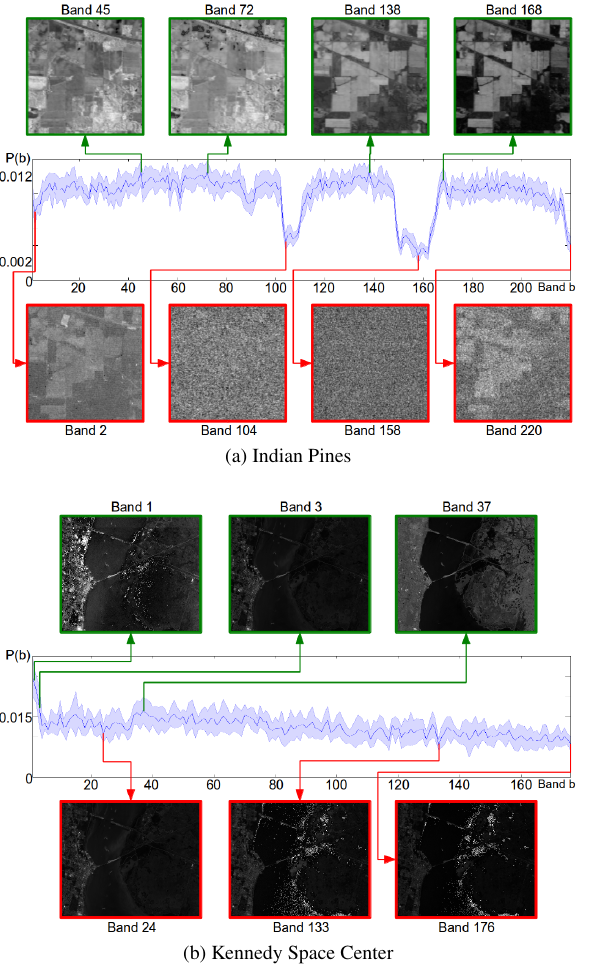
Figure 4: Usage frequency of spectral bands with exemplary in- formative and noninformative